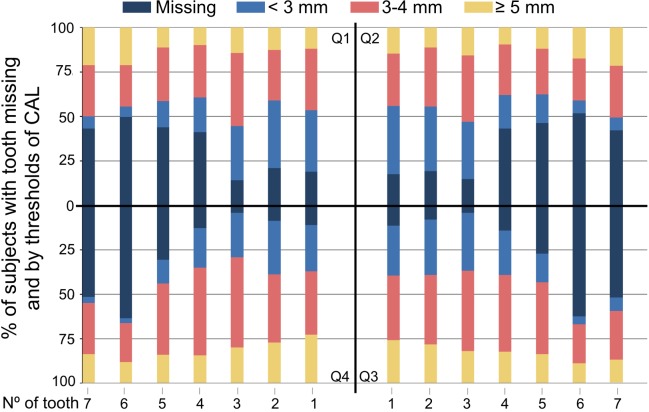
Percentage of subjects with the respective tooth present and by thresholds of CAL (mm), at each specific position, for all teeth in all quadrants.The black lines indicate the separation by each quadrant. Dark blue, percentage of missing teeth; Blue, percentage of teeth with less than 3 mm of CAL; pink, percentage of teeth with 3–4 mm of CAL; yellow, percentage of teeth over 4 mm of CAL.